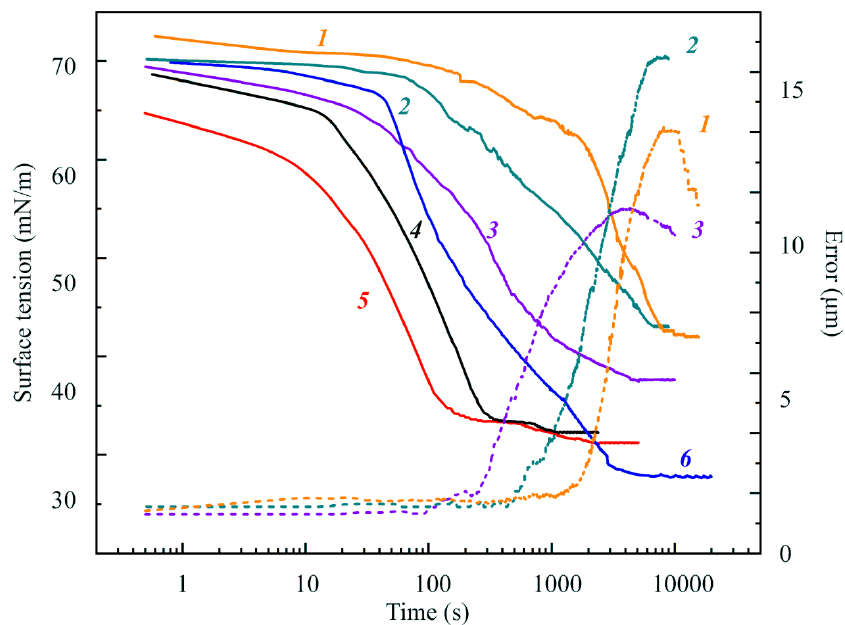
Figure 6. Dependencies of the dynamic surface tension (solid lines) and the Error (dashed lines) on time for drops of C 14 EO 8 aqueous solutions at di ff erent concentrations: 1 , 0.5; 2 , 2; 3 , 4; 4 , 10 and 5 , 20 µ mol / L for the drop formed at the capillary of 2 mm in diameter for equal initial drop volumes (10 mm 3 ) in air saturated by hexane vapor. At surfactant concentrations of 10 and 20 µ mol / L, the Error is within 1.0–1.5 µ m and is not shown in the Figure. Curve 6 (reproduced from Figure 2) represents the dependence of dynamic surface tension on time for pure water drop with the same initial volume formed at the same capillary.